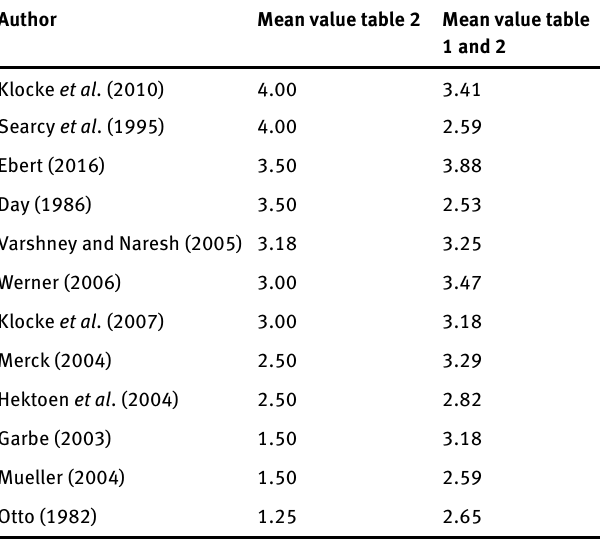
Table 3: Mean value of selected studies after applying the